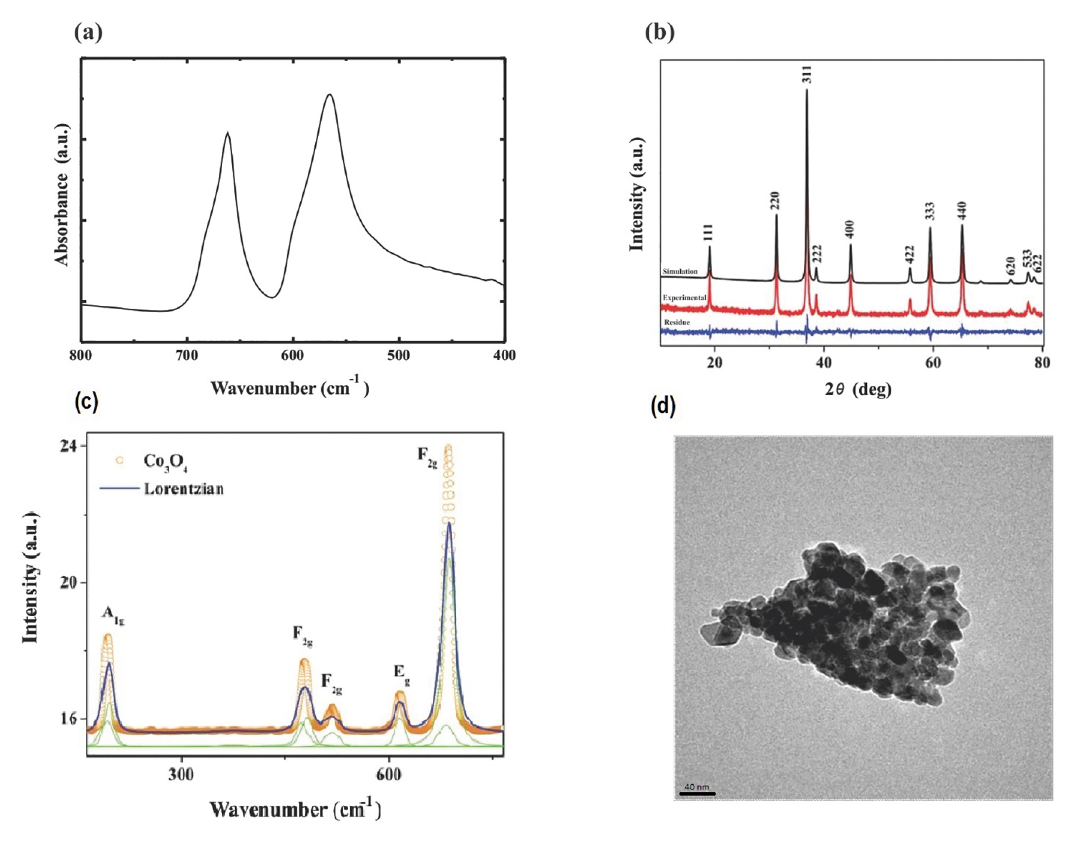
O nanoparticles. (b) XRD pattern for Co 3 4